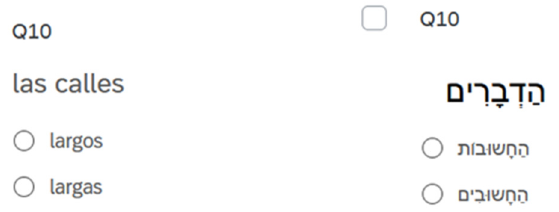
Figure 2. FCT experimental tasks in each target language.